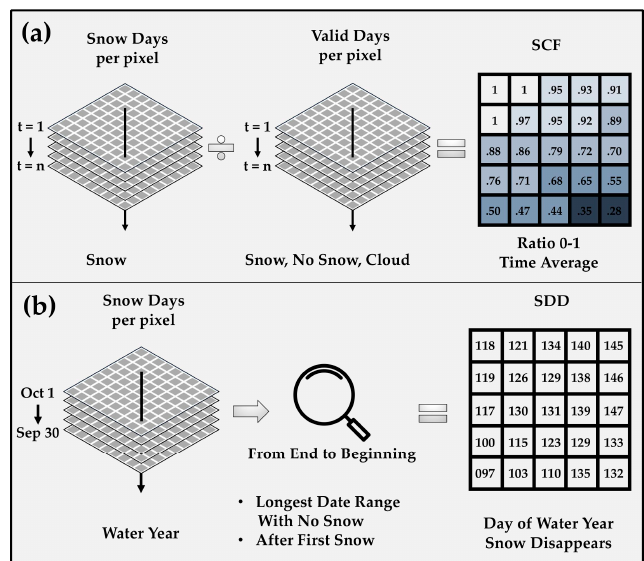
Figure 1. ( a ) An idealized schematic representing the snow cover frequency (SCF) algorithm in Google Earth Engine (GEE). The number of satellite observed snow days, along with a cloud correction, are divided by the valid number of observations from the same time period to create an image that contains the number of days snow was observed in each pixel. ( b ) An idealized schematic representing the snow disappearance date (SDD) algorithm in GEE for a water year in the Northern Hemisphere. The SDD algorithm builds a yearly image collection based on the water year from October 1 to September 30, and searches from end to beginning for the day when the pixel switches from snow covered to no-snow.